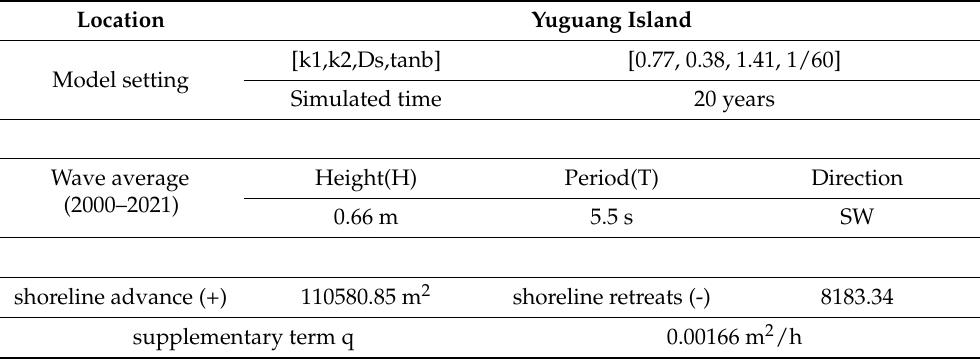
Table 5. Parameters and results of Case